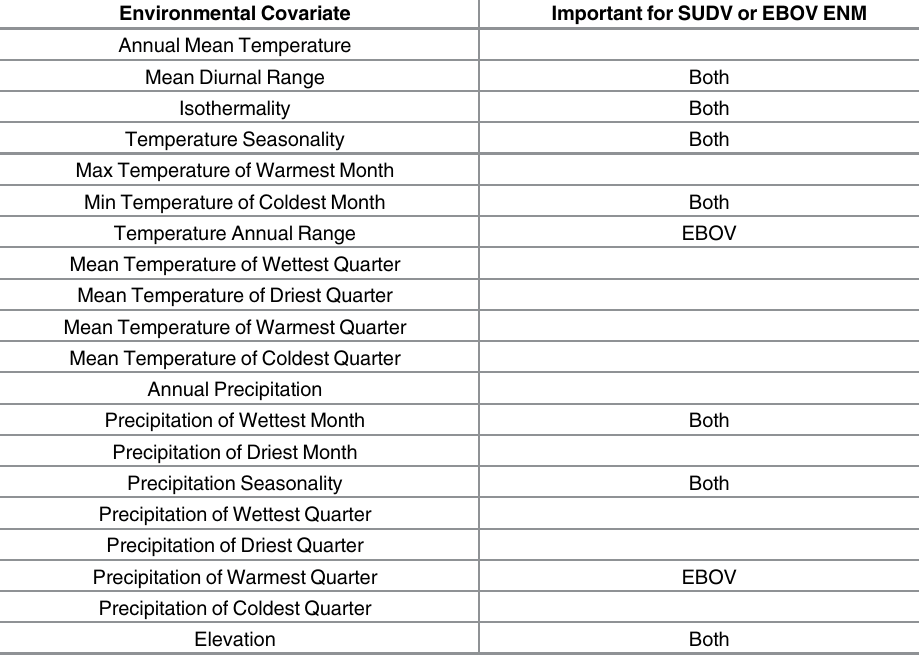
Table 2. Environmental covariates used to create